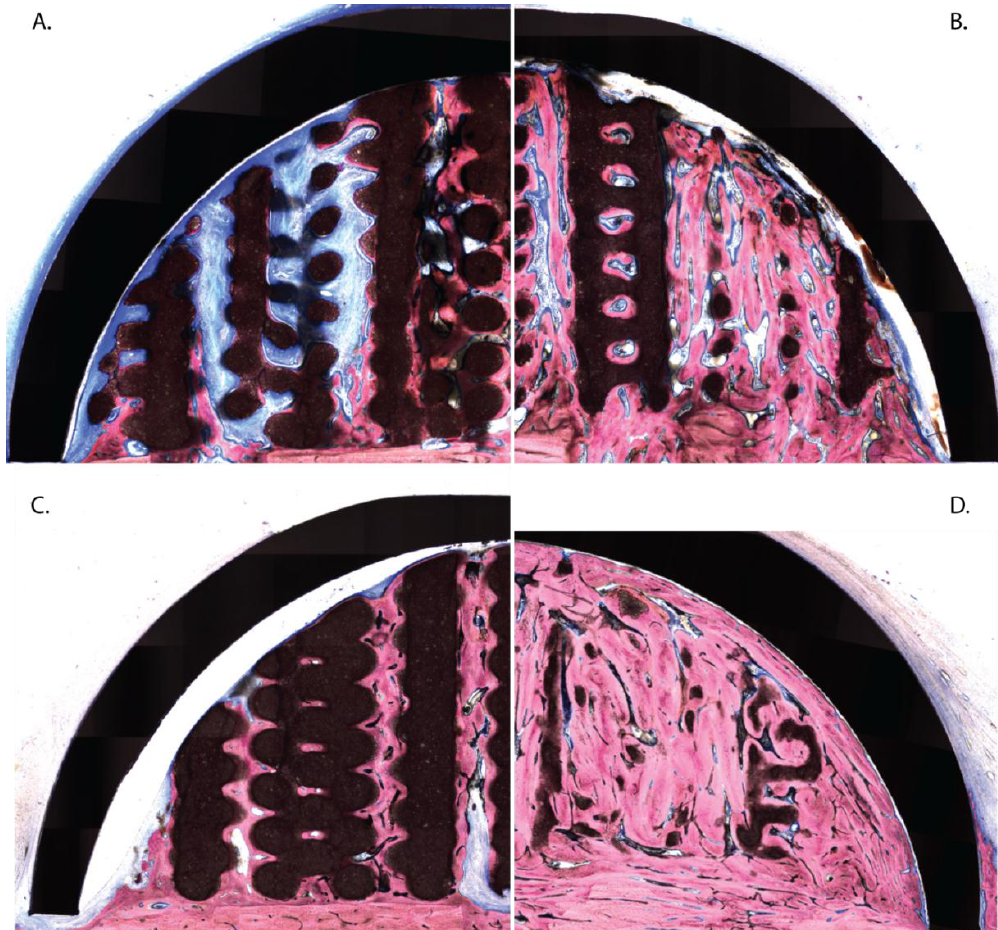
Figure 2. Hemi-slide showing the bone substitutes’ engraftment under the titanium caps at 8 and 16 weeks. ( A ) 3D construct (8 weeks); the construct appears as brown circles or rounded polygons. The newly formed bone (pink) sprouts from the transcortical perforations and the bony bed. It then develops into vertical columns up to the titanium caps. The remainder of the volume is filled with fibroid and osteoid tissue (blue); ( B ) BMP-2 primed construct (8 weeks); large portions are filled with new bone already entering the remodeling process. Some particles of bone substitute appear as largely degraded and intimately nested into the new bone. Other portions of bone substitute remain undegraded; ( C ) 3D construct (16 weeks); fibroid and osteoid tissue is replaced by maturing new bone. The bone substitute did not resorb; ( D ) BMP-2 primed construct (16 weeks); traces of bone substitute (largely imbricated into a mature bone) are still